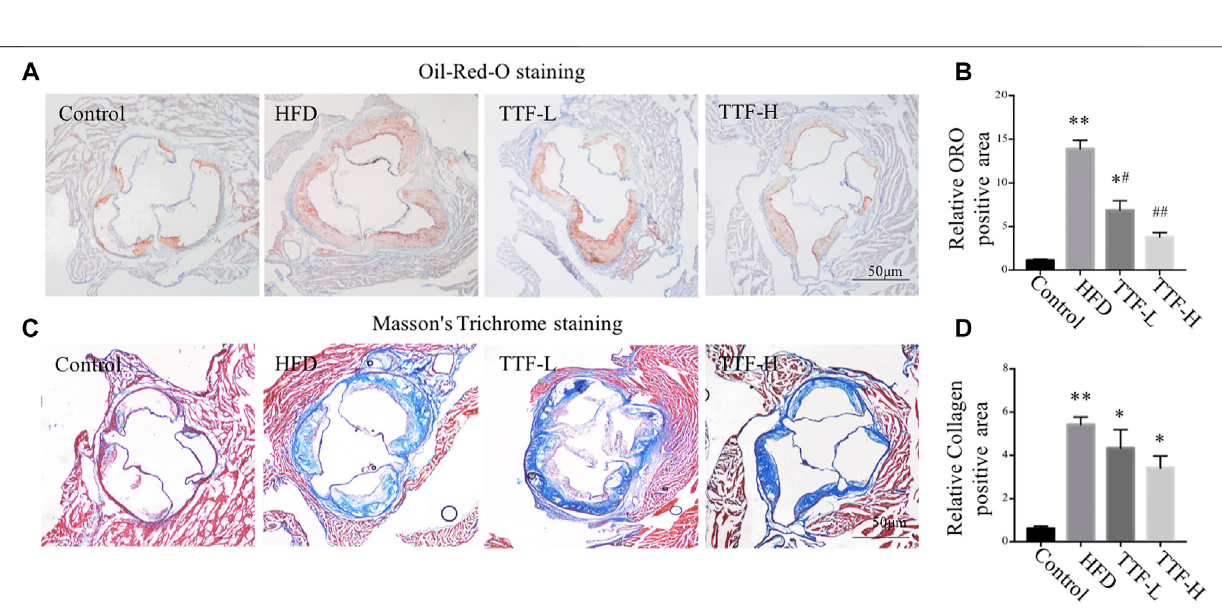
Frontiers in Pharmacology |